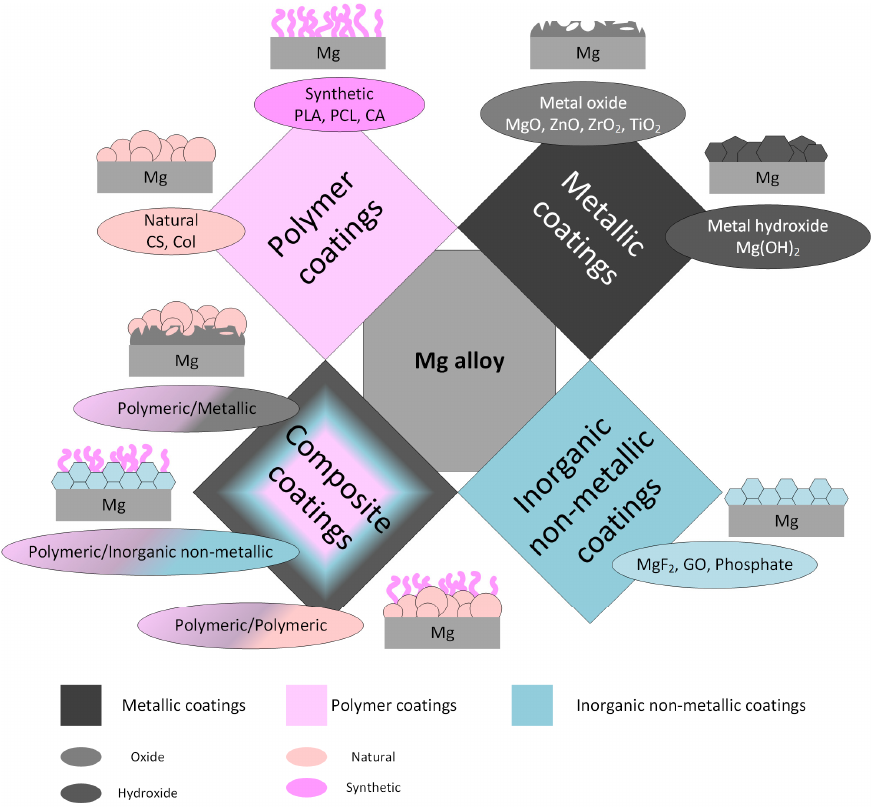
Figure 1. Main types of coatings for Mg-based alloys.